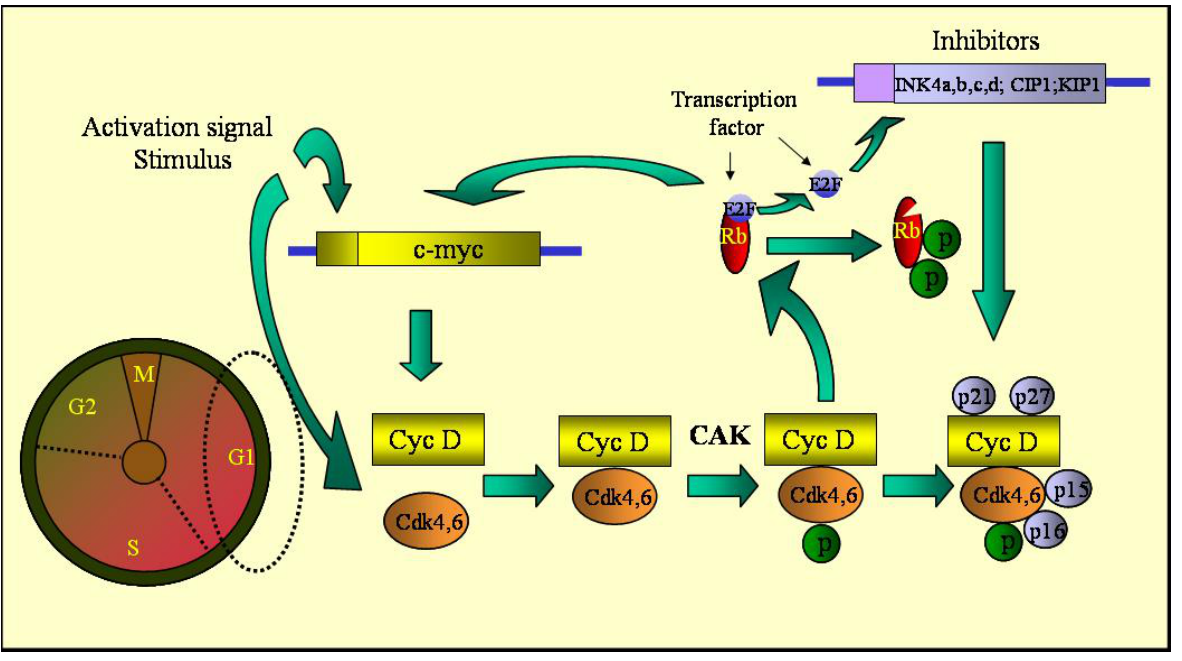
FIGURE 2. The G1 phase: cyclin D/Cdk4 or Cdk6 phosphorylate and inactivate Rb releasing E2F (which stimulates the transcription of genes necessary for cell cycle progression). INK4 CKIs bind only to Cdk4/6, inhibiting their activation by cyclin D, while Cip/Kip CKIs are acting as assembly factors for cyclin D and Cdk4/6. These CKIs inhibit the phosphorylation of Rb and thus leads to cell cycle arrest in